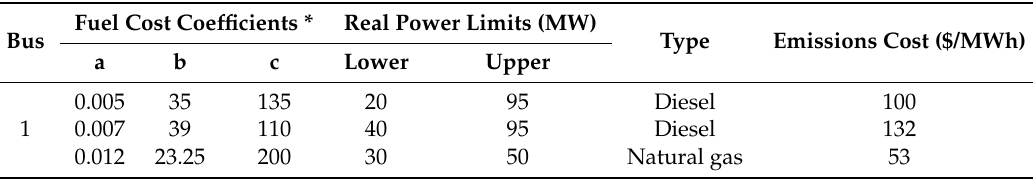
Table 3. Bus 1 associated data for